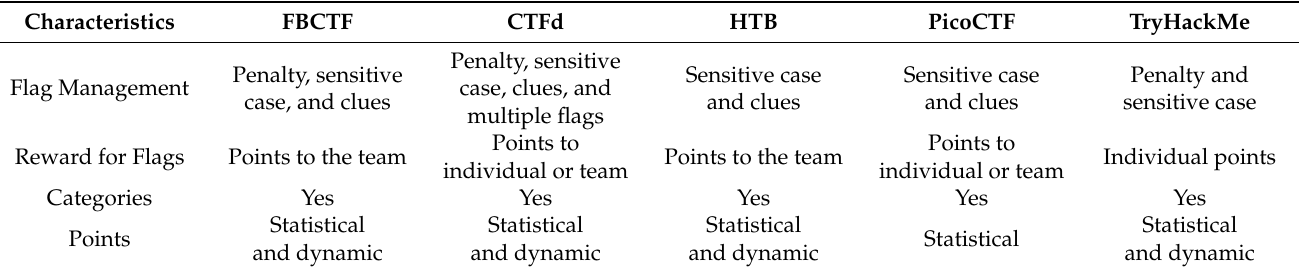
Table 3. Analysis of the evaluation for the criteria of the characteristics in the CTF platforms.